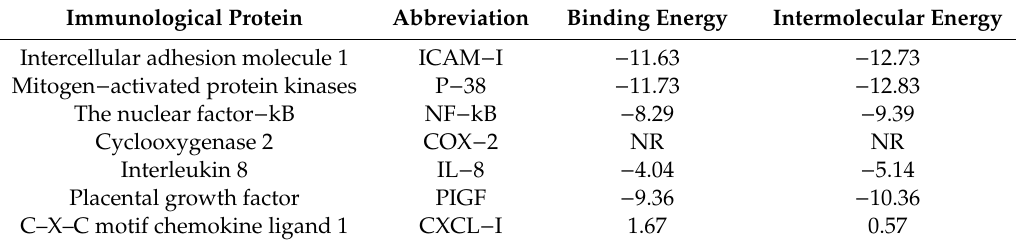
Table 3. Some immunological proteins–TiO 2